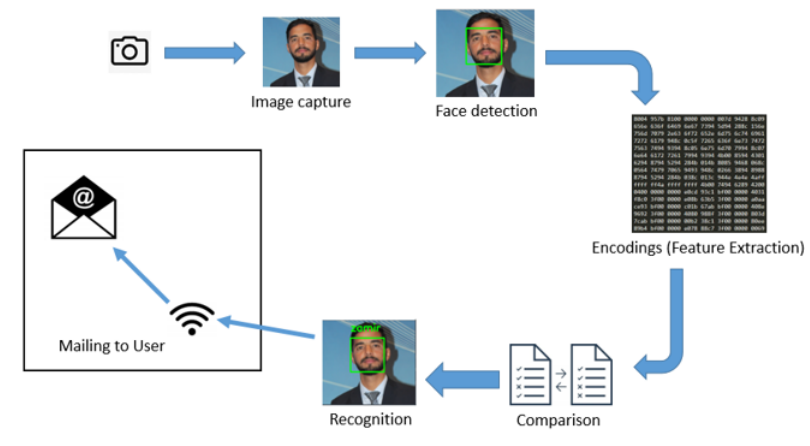
Figure 3. Proposed